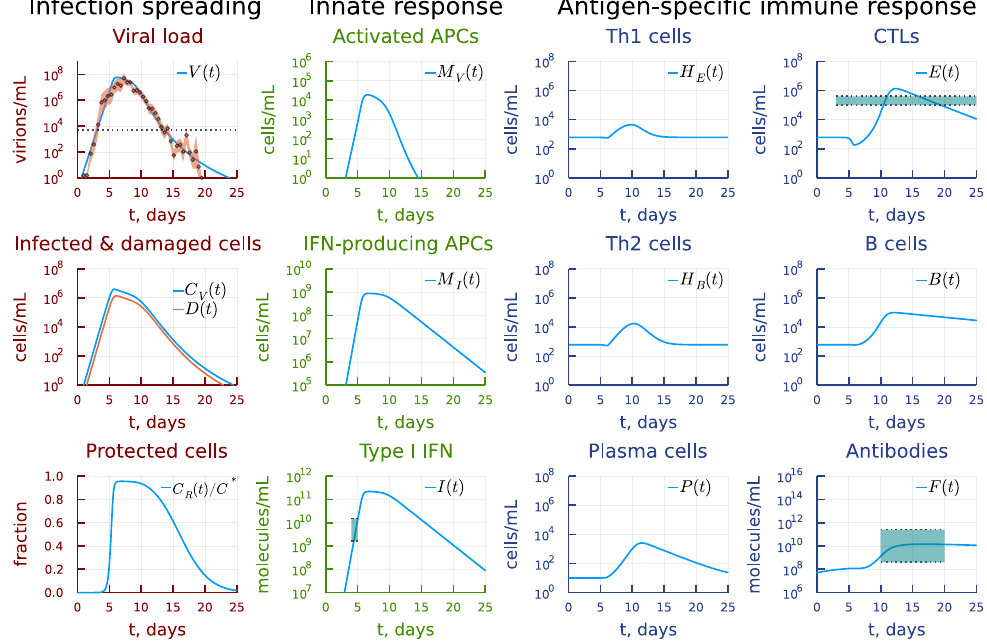
Figure 2. Baseline solution of the model describing the intra-host SARS-CoV-2 infection dynamics and the available clinical data. The inter-patient variability of the viral load data is presented as a pink shaded area. The scale of the type I interferon response and the serum levels of antigen-specific antibodies and CTLs are shown as green shaded areas. The dotted line on the viral load panel refers to the median level of viral load on the day of symptoms onset